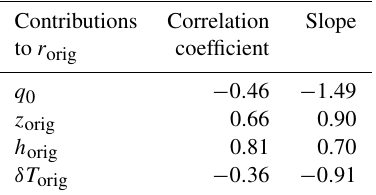
Table 7. Same as Table 4 but for the STRASSE observations. Linear regressions are calculated among 55 data points, so that correlation coefficients above 0.35 are statistically significant at